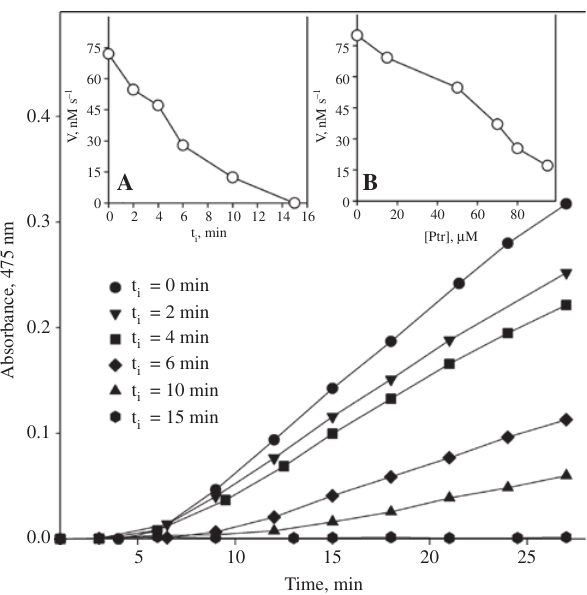
Figure 3: Determination of the tyrosinase activity in solutions (1 mM KH PO , pH 6.5) irradiated at room temperature in the presence of 2 4 pterin (95 μ M). For each sample, the formation of L-dopachrome was followed by measuring the absorbance at 475 nm as a function of the time elapsed after adding L-tyrosine as the substrate (37 ° C). Inset: reaction rates (V) determined in the linear phase as a function of (A) irradiation time ( t ) ([Ptr] = 95 μ M), (B) Ptr concentration after i 12 min of irradiation.